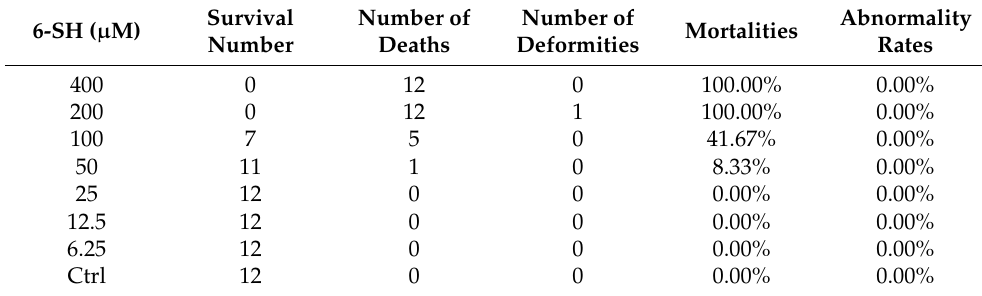
Table 1. The mortalities and abnormality rates after 6-SH treatment for 96